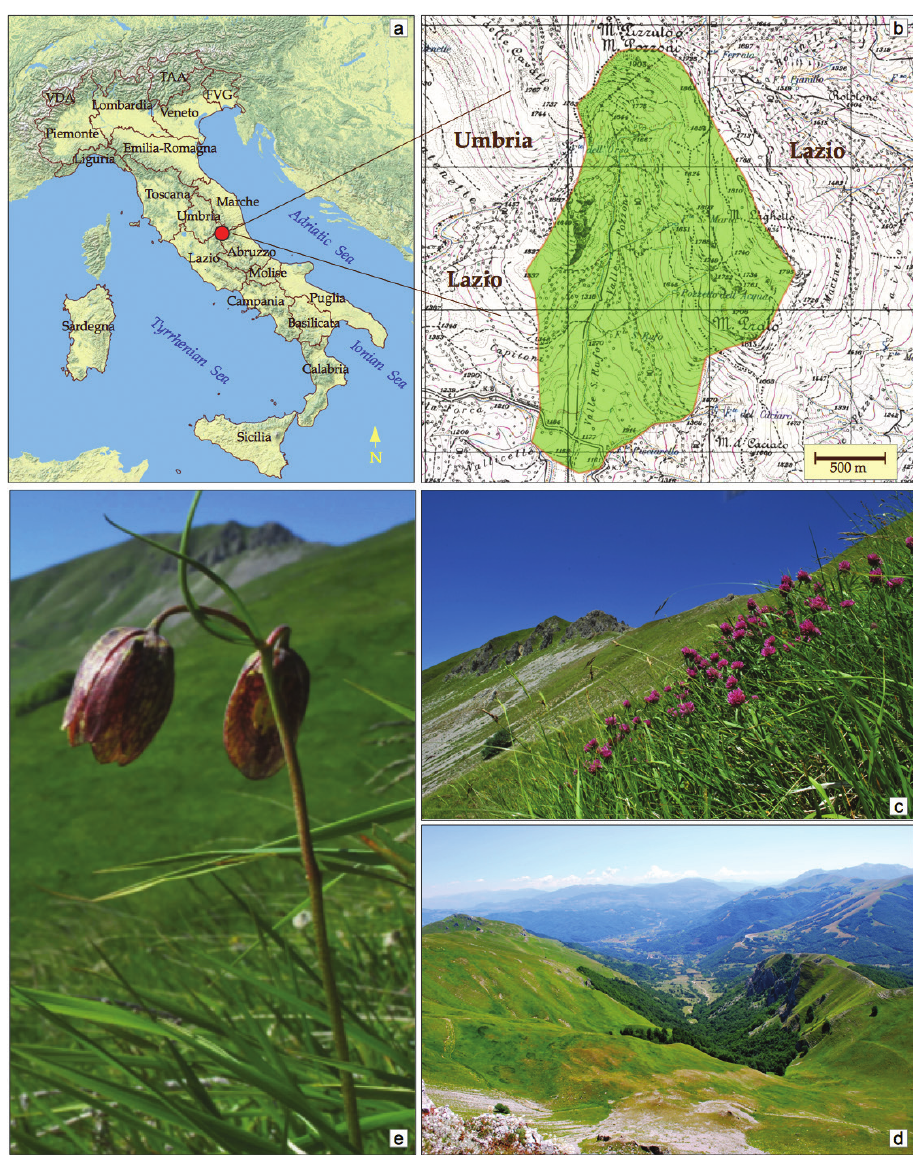
Figure 1. Study area location ( a ) and its landscape ( c–e ) b the limits of study area drawn on I.G.M.I-1:25,000 topographic map c high mountain pastures of Mt. Pozzoni dominated by Brachypodium genuense (DC.) Roem. et Schult. with Trifolium alpestre L. e Fritillaria montana Hoppe ex W.D.J.Koch, a rare species considered “Near Threatened” for extinction risk. Photos: R. Tranquilli and E. Del Vico. on Pignatti (1982) and Flora Europaea (Tutin et al. 1968, 1972, 1976, 1980, 1993). Taxa delimitation was based on Anzalone et al. (2010) and nomenclature accords to Bartolucci et al. (2018), Galasso et al. (2018) and the subsequent updates